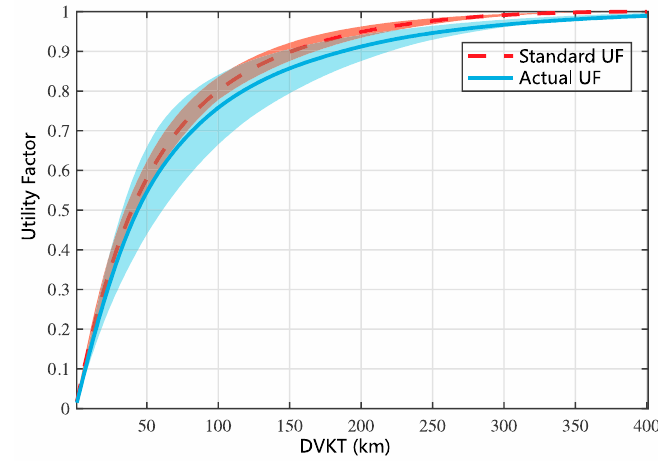
Figure 4. Standard UF and Actual UF. Table 5. Standard UF and actual UF in the seven cities.